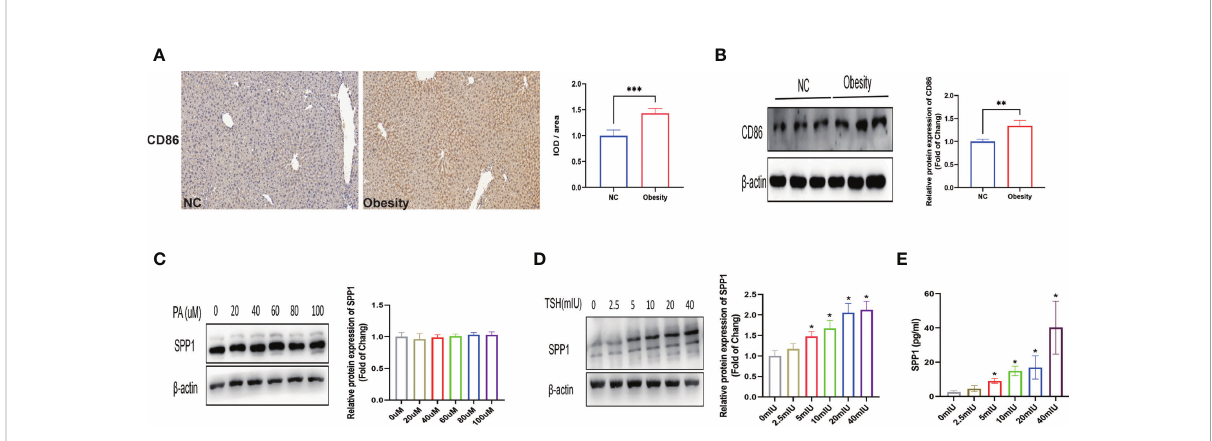
FIGURE 7 TSH acts to promote secretion of secreted phosphoprotein 1 (SPP1) in M1 macrophage cells. (A) Immunostaining of CD86 in mice livers. (B) Quanti fi cation of the average band densities calculated from western blots of CD86 in liver tissues. Protein levels of SPP1 stimulated with palmitic acid (PA) (C) or thyroid-stimulating hormone (TSH) (D) in M1 macrophage cells. (E) SPP1 in the supernatant after stimulation with TSH by ELISA. *p < 0.05, **p < 0.01, ***p < 0.001 vs. NC or 0 mIU TSH